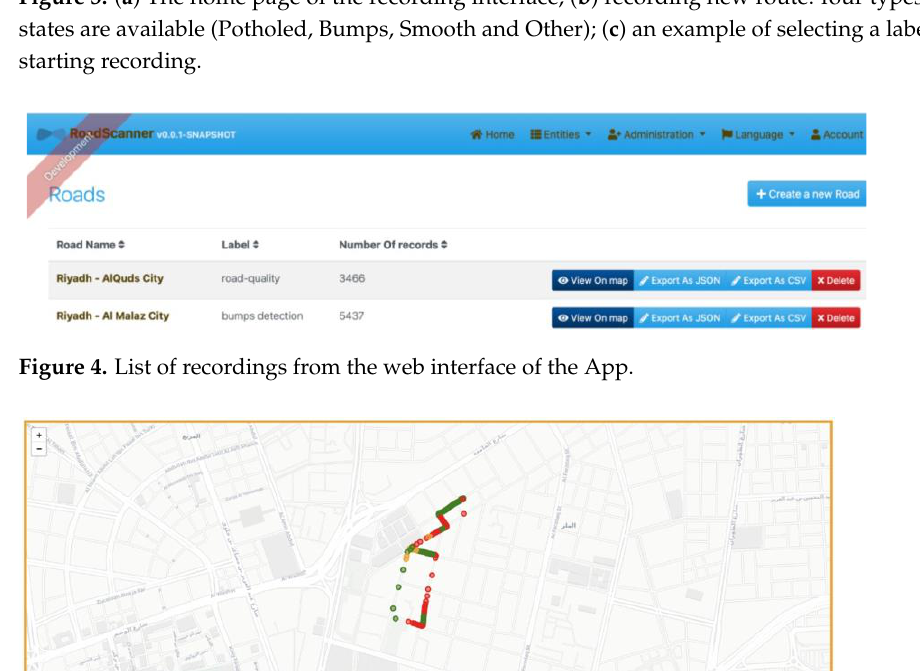
Figure 5. Map visualization with playback features. The circles represent samples of recording while their colors represent their corresponding labels (“Potholed”, “Bumps”, “Smooth”, and “Other”). 5. Experiments 5.1. Experiments Presentation In this section, we introduce the experiment part of our work. As previously men- tioned, we aim to train machine learning models to be able to detect road states. To this end, we have built a new dataset containing two types of road status: smooth and pot- holed. For each labeled segment, multimodal sensorial data were recorded from the ac- celerometer and the gyroscope of a driver ’ s smartphone. As shown in Table 2 and Figure 6, a total number of seven features were recorded, namely the 3D accelerometer data (acc x , acc y , and acc z ), the 3D angular rotations from the gyroscope (gyro x , gyro y , and gyro z ), and the speed of the vehicle. Thus, we aim through machine learning models to map the data from the smartphone sensors to the correct label (smooth or potholed). Technically this problem can be solved by a binary classification approach. Table 2 . A sample of the data used in the experiments. speed